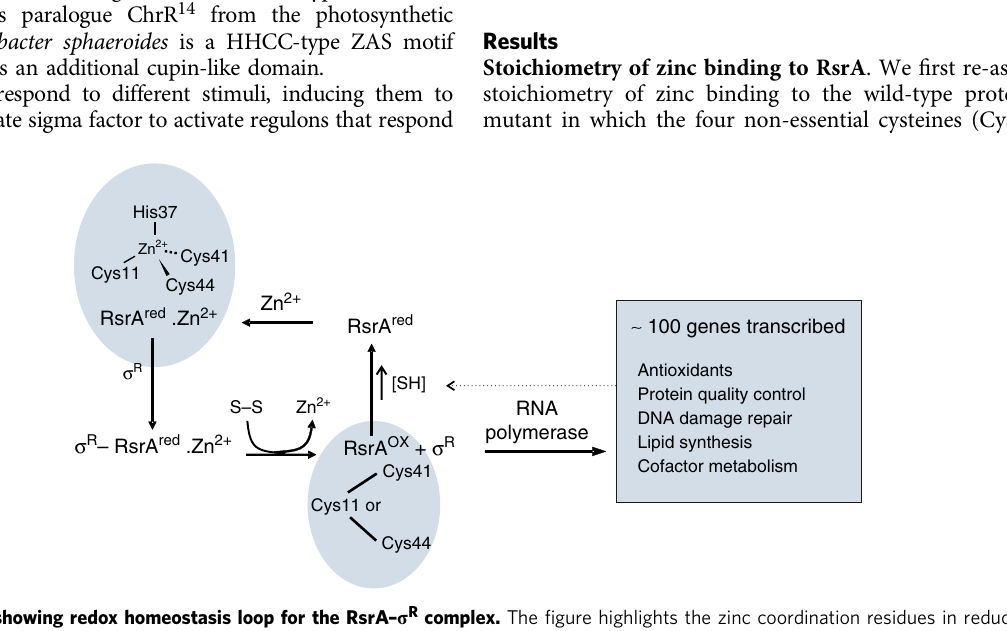
Figure 1 | Scheme showing redox homeostasis loop for the RsrA– r R complex. The figure highlights the zinc coordination residues in reduced RsrA (RsrA red .Zn 2 þ ) from Streptomyces coelicolor . Disulfide stress results in the loss of zinc and formation of a degenerate trigger disulfide bond in RsrA ox , formed by the same zinc-binding residues. The transcribed regulon of s R includes anti-oxidant genes that re-establish redox homeostasis and the genes for sigR and rsrA (not shown), which amplify the response. Not shown is an additional layer of regulation involving a form of s R with an N-terminal extension that also binds RsrA, but is rapidly degraded by proteolysis 65 . Shaded panels denote NMR structures of RsrA reported in the present work. NATURE COMMUNICATIONS|7:12194|DOI: